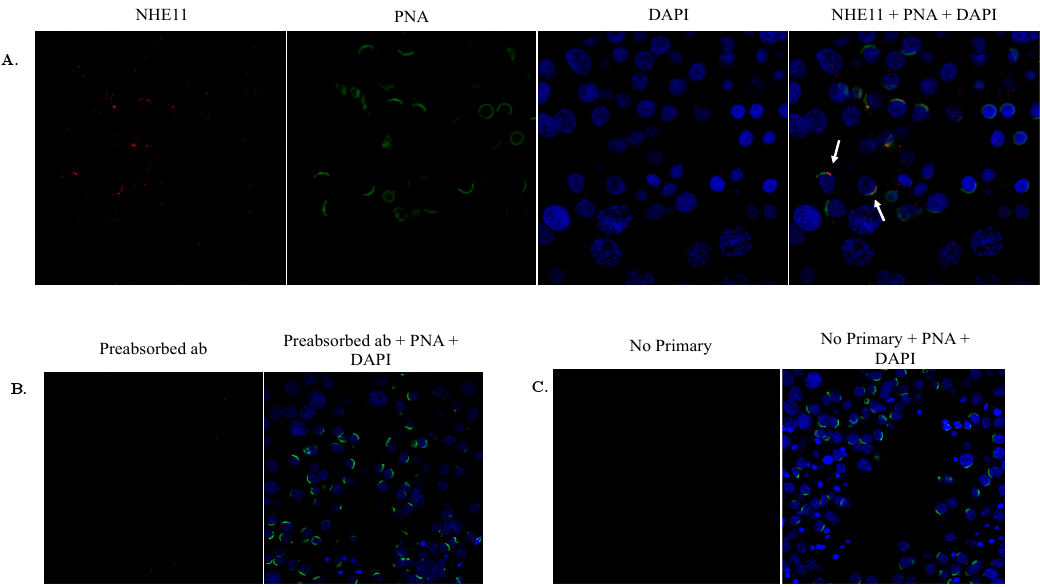
Figure 5. Immunohistochemical localization of NHE11 in human testis sections. ( A ) Immunolocalization of NHE11 in human testis sections using our anti-NHE11 antibody and a goat anti-rabbit Alexa 594 secondary antibody (red). PNA-FITC was used to stain the acrosome (green) and DAPI was used to counterstain the nuclei (blue). Note that NHE11 staining of the acrosome is observed in spermiogenic cells, with a very similar staining pattern to what is seen in the rat testis